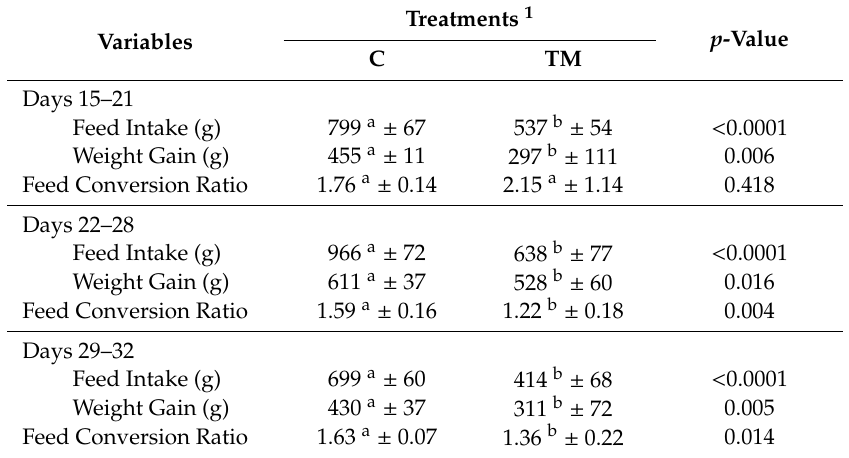
Figure 1. Biplot of multidimensional preference analysis for the consumption of test ingredients from day 15 to 32 of birds’ age (S = Extruded semi-whole soybean meal, N = Supplement mixture, M = Ground corn, T = TM meal). Table 7. Feed intake, weight gain, and feed conversion ratio of the C group and TM group per period (average / bird ± standard